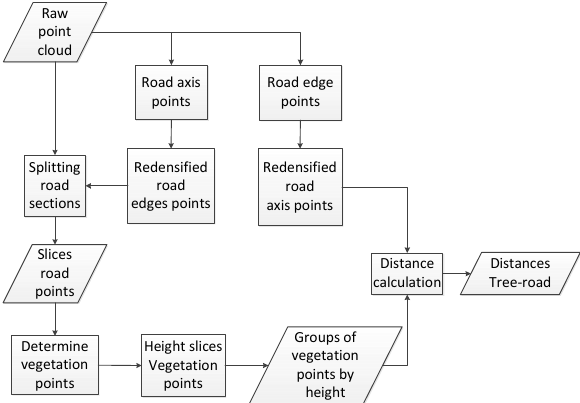
Figure 4. Workflow of the methodology to calculate distances between vegetation and road.